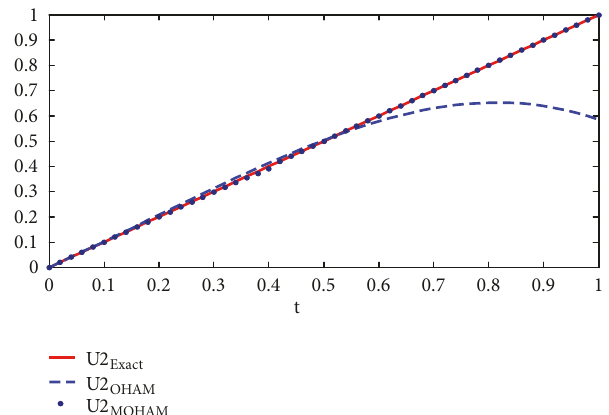
Figure 6: The results of OHAM, MOHAM, and exact solution for u2 in Example